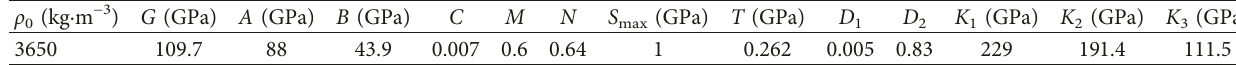
Table 5: Main parameters of the ceramic model.